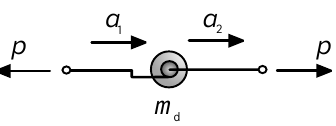
Figure 1. A single-degree-of-freedom (SDOF) structure with a CBIS: ( a ) structure with a CBIS and ( b ) detail of a CBIS. Note that the conductor plates serve as flywheels.